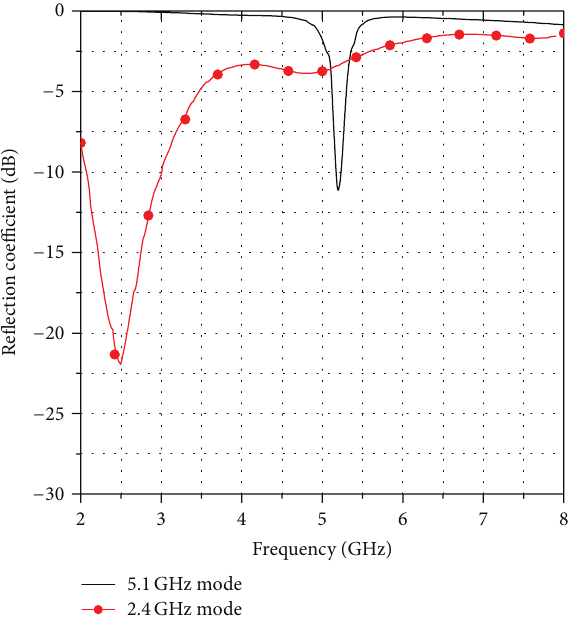
Figure 9: Numerical results of the reconfigurable filtenna reflection